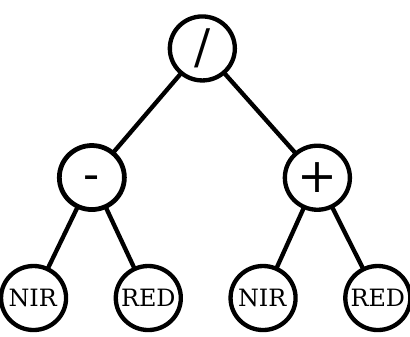
Figure 4. Syntax tree representing the